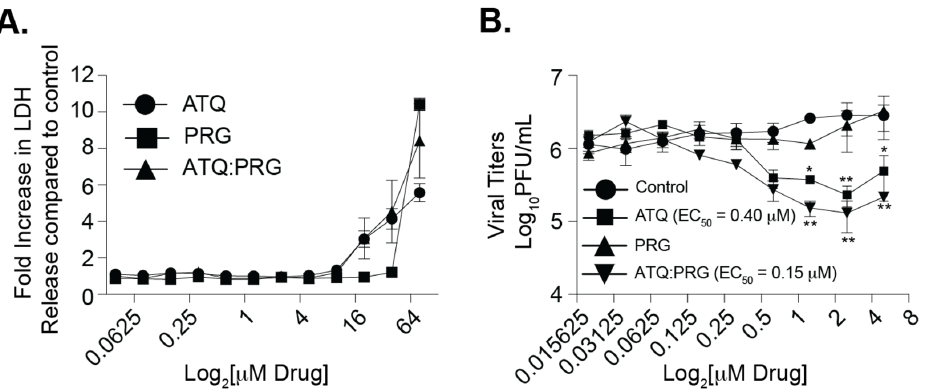
Figure 2. Effect of Malarone on SARS-CoV-2 replication. ( A ) Cell cytotoxicity after 36 h compound treatment quantified by LDH release assay. Two independent experiments with internal technical duplicates. ( B ) Vero E6 cells were pretreated with increasing concentrations of atovaquone (ATQ), proguanil (PRG), or the combination of ATQ and PRG (ATQ:PRG), infected with SARS-CoV-2 at a MOI of 0.1. Viral titers in the supernatant were quantified at 36 hpi by plaque assay. Data represent the mean and range of two independent experiments with internal technical duplicates. * p < 0.05, ** p < 0.01. Two-way ANOVA.